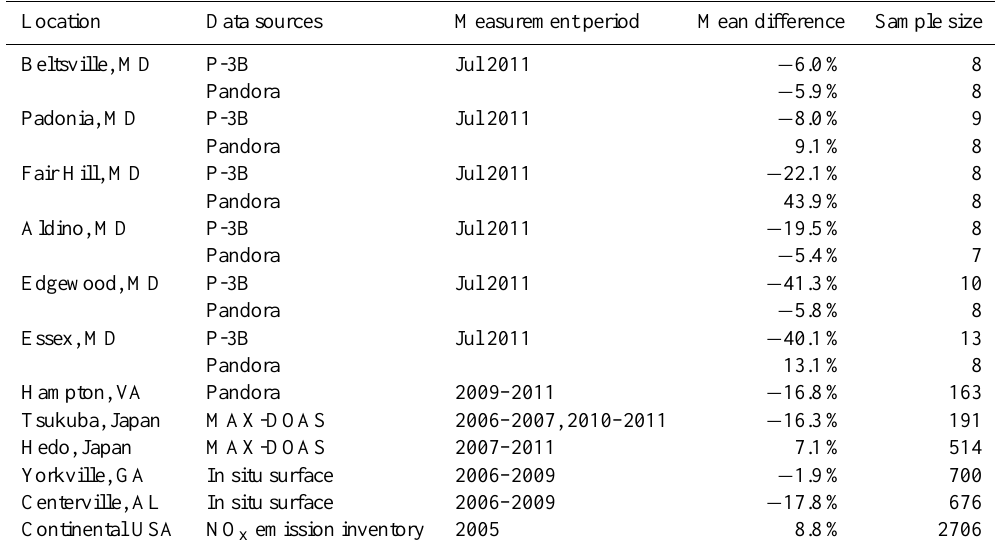
Figure 12. (top) Annual mean surface NO x emissions over the United States for 2005. The left panel contains bottom-up emissions from fos- sil fuels, bio-fuels, biomass burning, and soils. The right panel shows top-down emissions estimated using OMI tropospheric NO 2 columns. The bottom left panel shows the difference between top-down and bottom-up surface NO x emissions. (bottom right) Monthly mean ratio of area-averaged top-down surface NO x emissions to bottom-up emissions over the United States. Table 2. Summary of validation